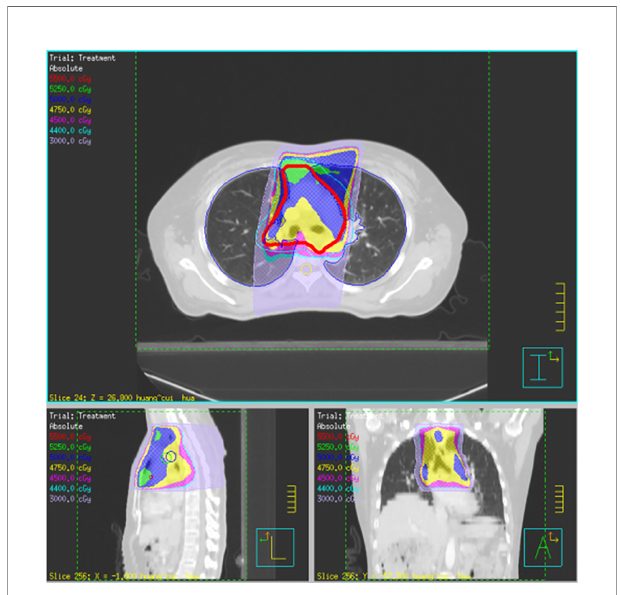
FIGURE 2 | Postoperative radiotherapy for